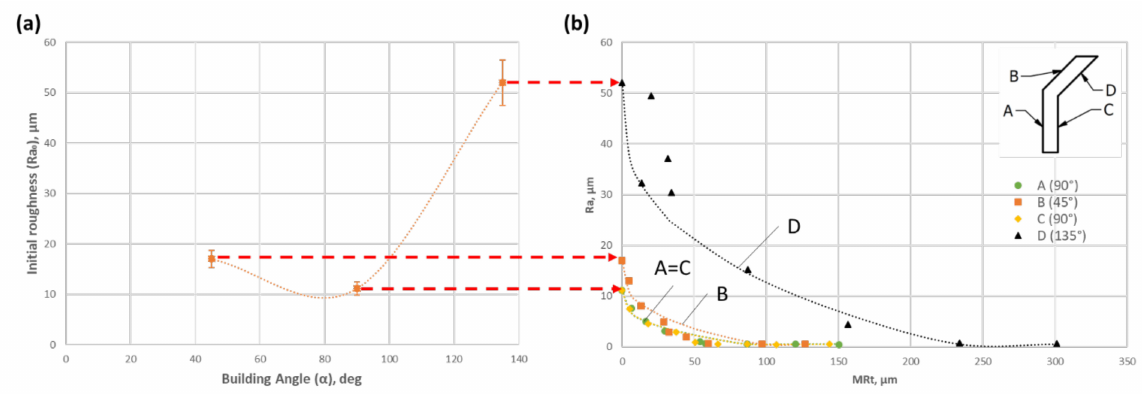
Figure 18. As-built V-shape artifact: ( a ) Ra 0 ( α ) ; ( b ) Ra ( Ra 0 , MR t ) , where points correspond to experimental measurements and dotted lines, to the best-fit